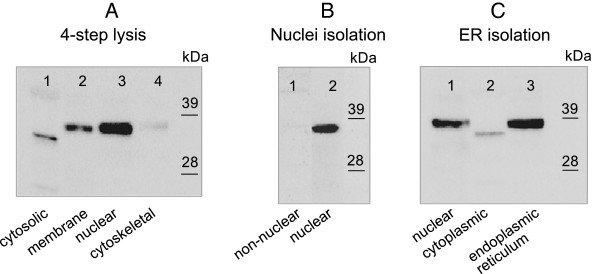
Western blot of the cell fractionation experiments A) 4-step lysis, B) nuclei isolation and C) ER isolation. Using the C-terminal, anti-OPTC pAb, a 37 kDa band was detected in membrane, nuclear, and ER fractions (lanes A2, A3, B2, C1 and C3). A band of slightly smaller molecular weight (possible degradation/cleavage fragment) was detected in the cytosol fractions (lanes A1 and C2).